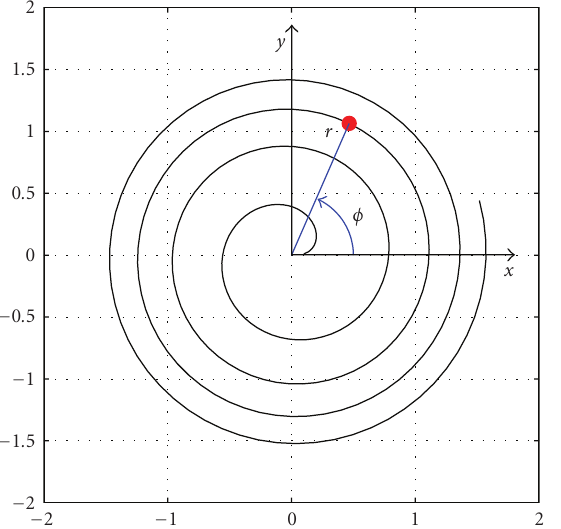
Figure 12: The Fermat spiral and its associated coordinate system.